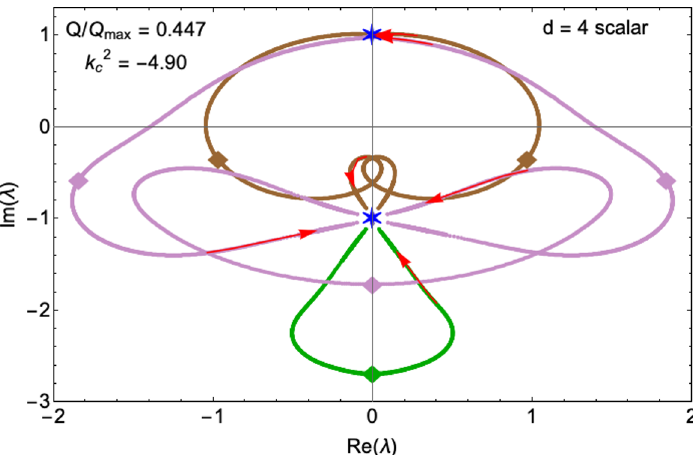
Figure 3 . Spectral curve for the sound hydrodynamic mode for d = 4 ; ~ Q = Q=Q max = 0 : 445, at (cid:12)xed j k j 2 = j k c j 2 = 4 : 90, which corresponds to the transition point between the blue branch and the green branch. The brown line corresponds to the hydrodynamic sound mode, the green line to a di(cid:11)usive non-hydrodynamic mode in the sound channel and the lilac line to the di(cid:11)usion mode. The pole collisions are indicated by the blue stars. At the critical point located at (cid:21) = (cid:0) i we see a collision between 4 QNMs implying a multiplicity 4 branch